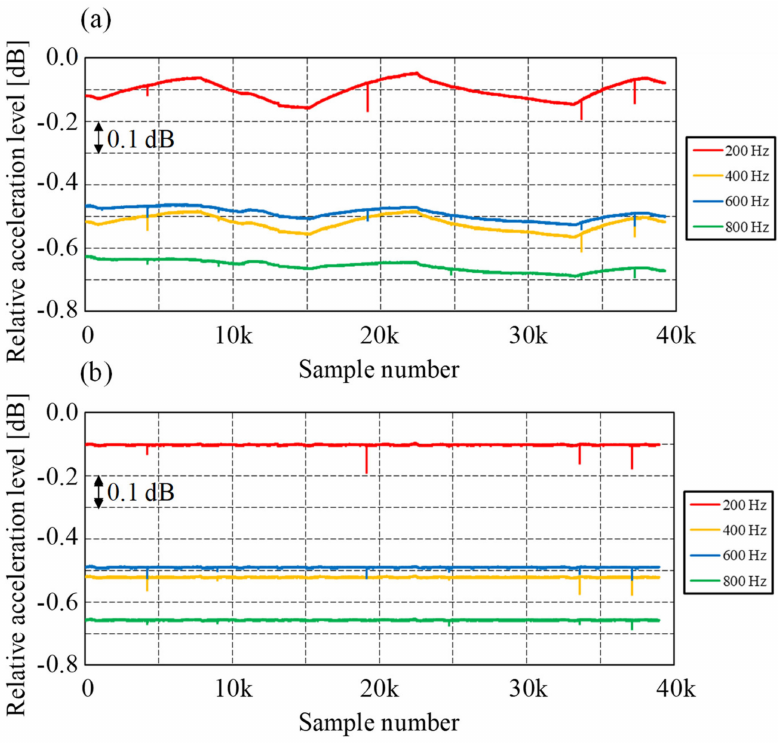
Figure 6. ( a ) Time-series data of the energy levels in each frequency band and ( b ) those treated with high-pass filtering.